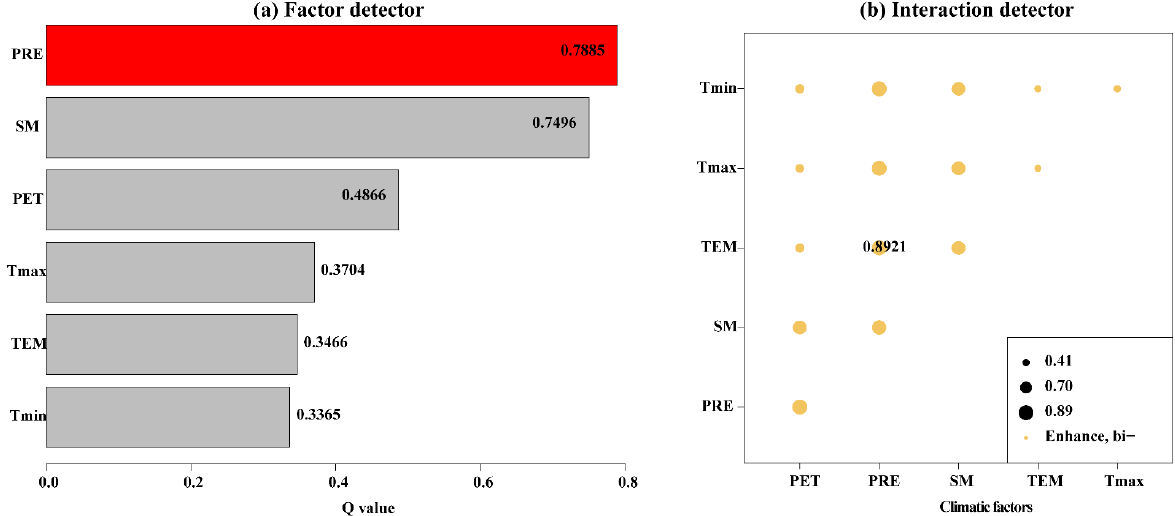
Figure 8. Results of ( a ) factor detector; and ( b ) interaction detector between climatic factors and mean NDVI during the growing season of 1982 – 2015 in the Mongolian Plateau.